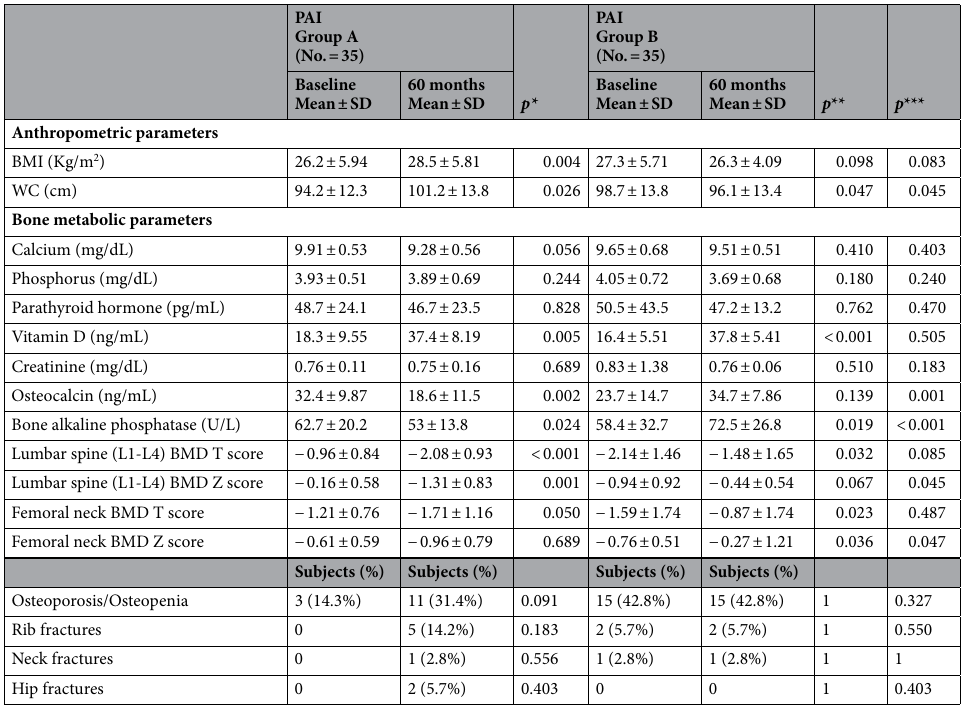
Table 3. Anthropometric and metabolic parameters in patients of groups A and B with primary adrenal insufficiency (PAI) at baseline and after 60 months of treatment. * p : comparison between baseline and 60 months of treatment in group A. ** p : comparison between baseline and 60 months of treatment in group B. *** p : comparison between groups A and B at 60 months of